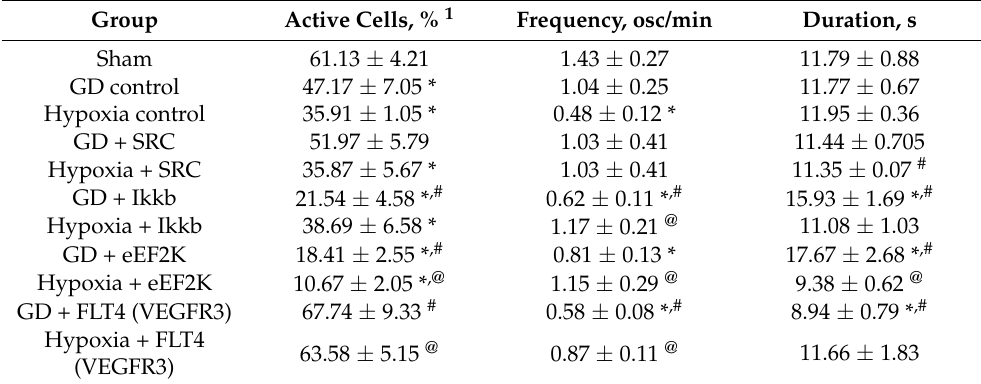
Table 3. The main parameters of the calcium activity of primary hippocampal cultures under the influence of ischemic factors together with the blockade of intracellular